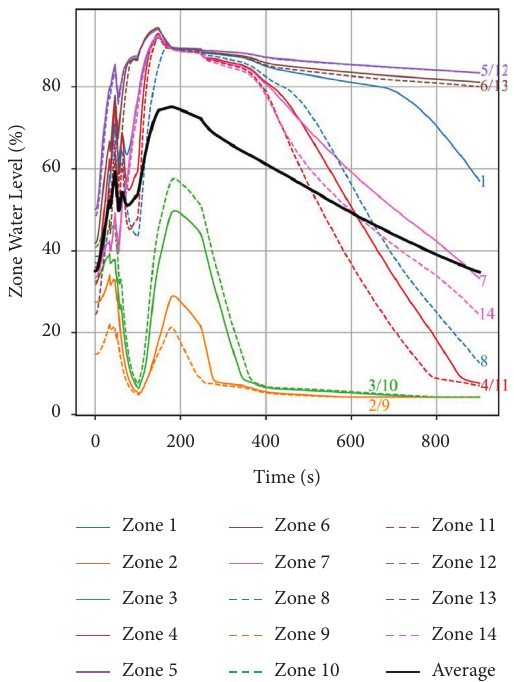
Figure 21: Liquid zone levels for adjuster rod failure transient.